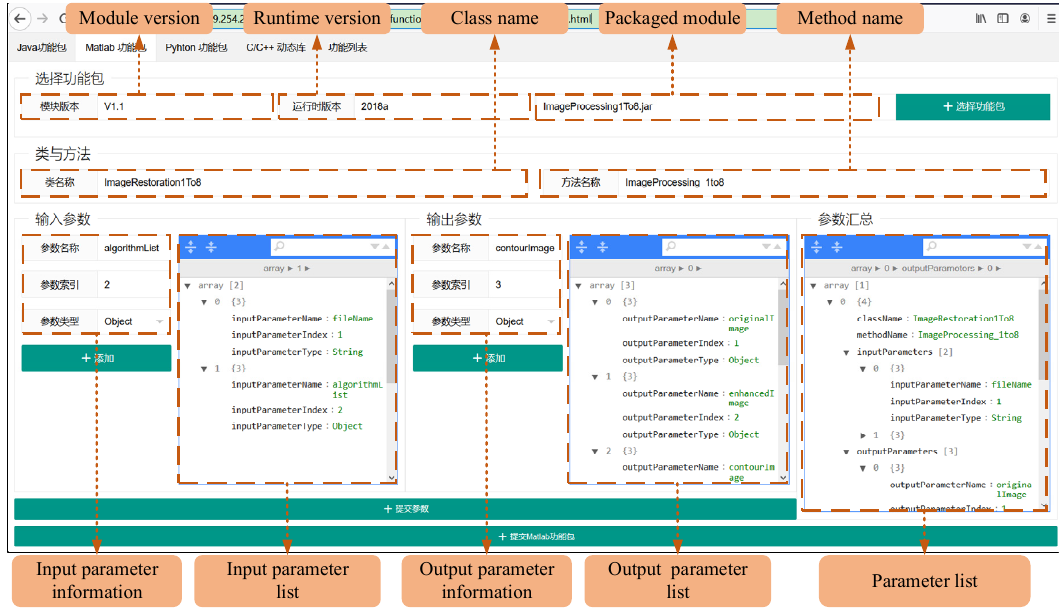
Figure 18. Submission of algorithmic and functional modules. Each parameter includes the name, index, and type of parameter. As the order of each parameter, the index is crucial.